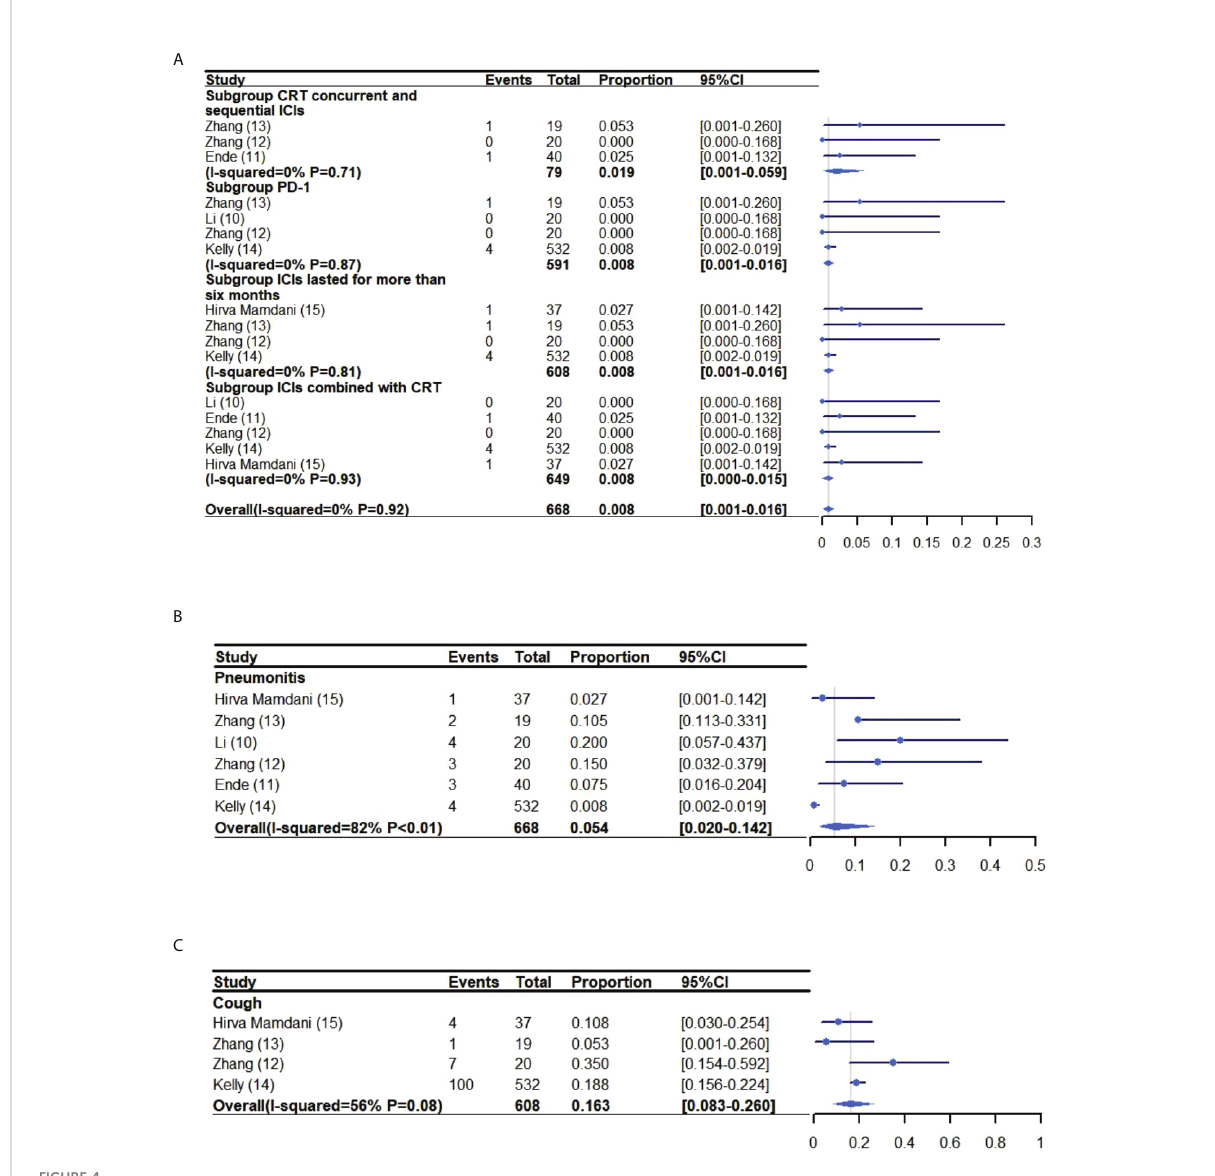
FIGURE 4 Meta-analysis and forest plot for esophageal cancer patients treated with CRT/RT and ICIs who experienced grade 3-5 Pneumonitis (A) , grade 1-2 pneumonitis (B) and cough (C) . CRT, Chemoradiotherapy; RT, Radiotherapy; ICIs, Immune checkpoint inhibitors; PD-1, Programmed death-1.